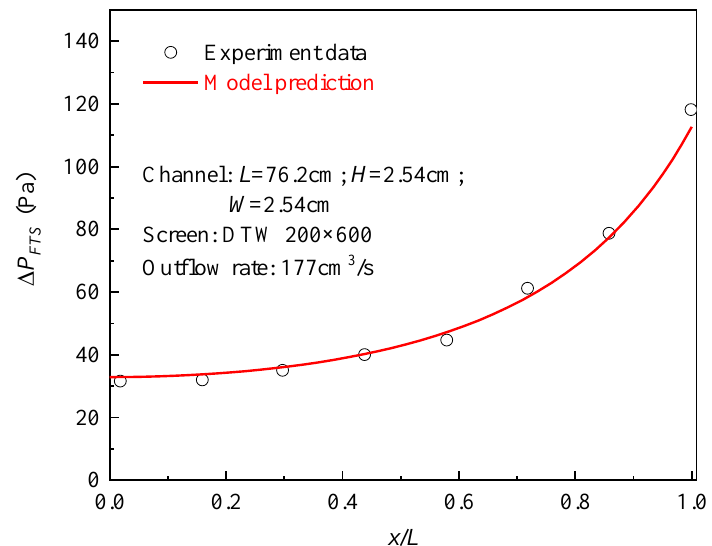
Figure 3. Comparison between model prediction and historical experimental